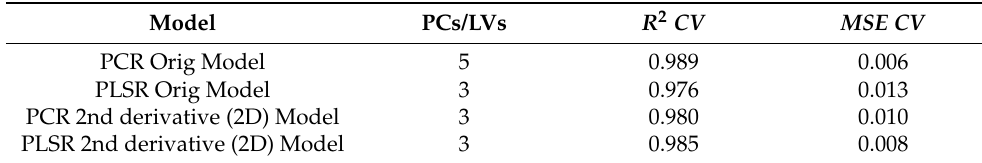
Table 2. Model summary (all values to 3 sig. figs.).